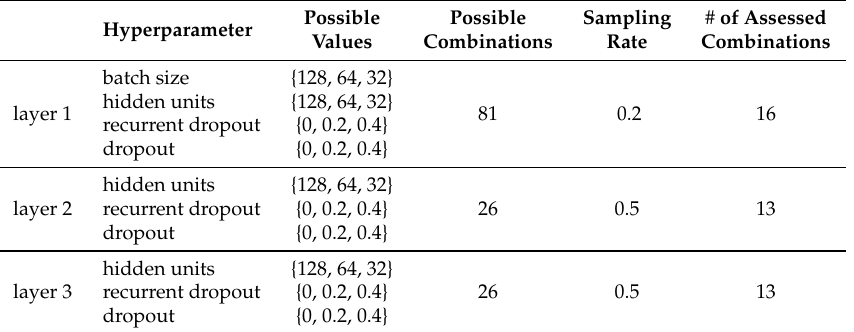
Table 1. The hyperparameters that were tuned for an optimal LSTM RNN model specification.